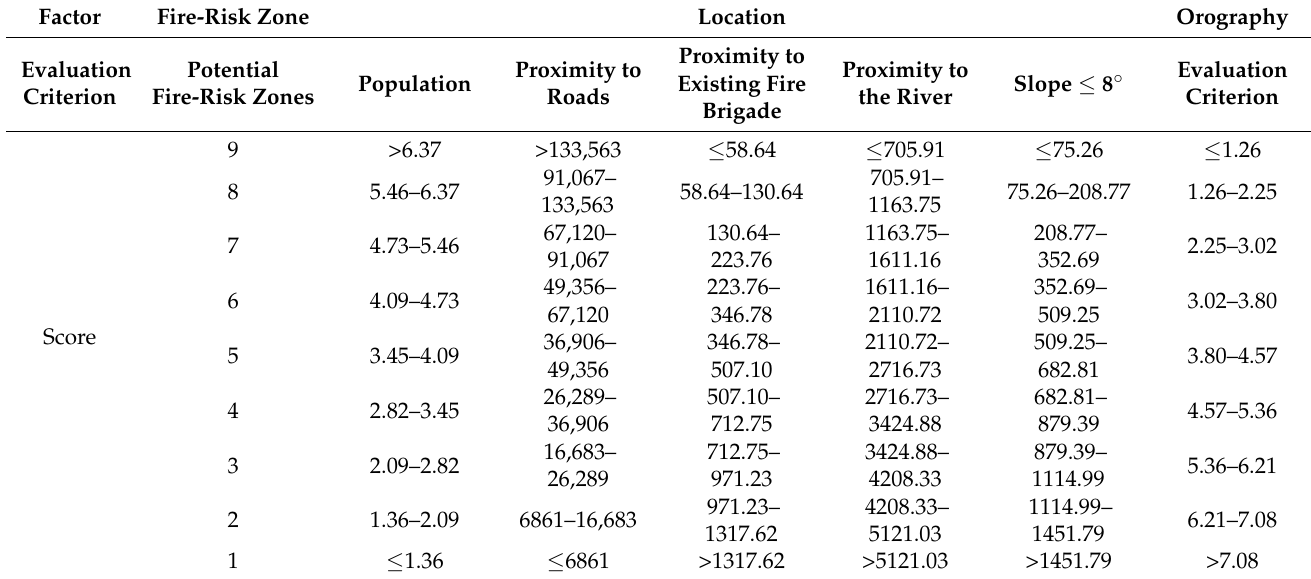
Table 9. Evaluation criteria reclassified with the corresponding scores and weight of criteria.